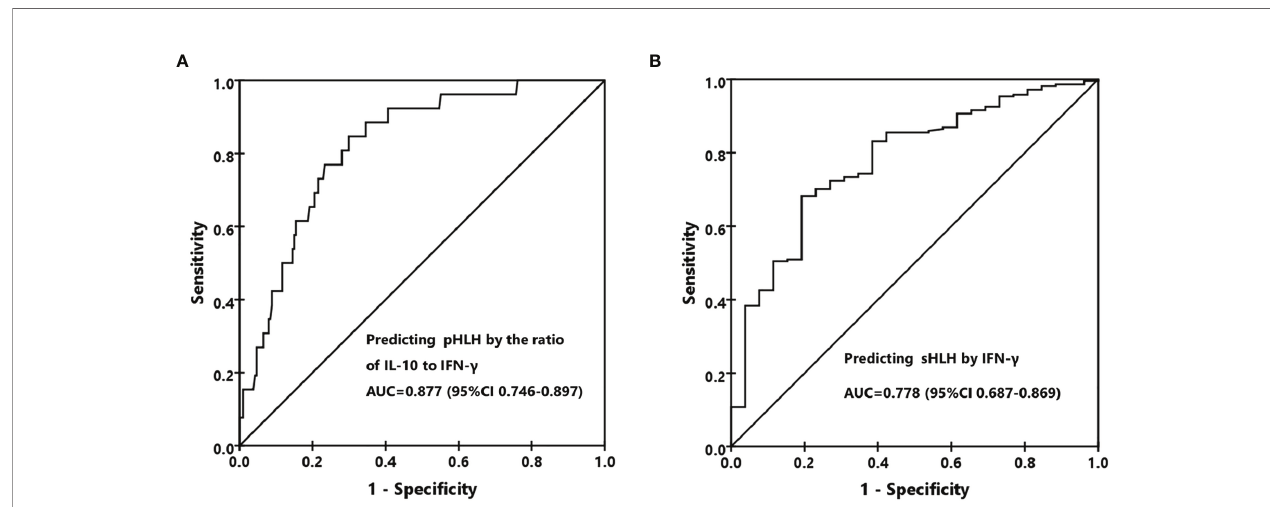
FIGURE 2 | Differentiation of primary HLH (pHLH) and secondary HLH (sHLH). (A) The receiver operating characteristic (ROC) curve for predicting pHLH by the ratio of IL-10 to IFN- g . (B) The ROC curve for predicting sHLH by the IFN- g